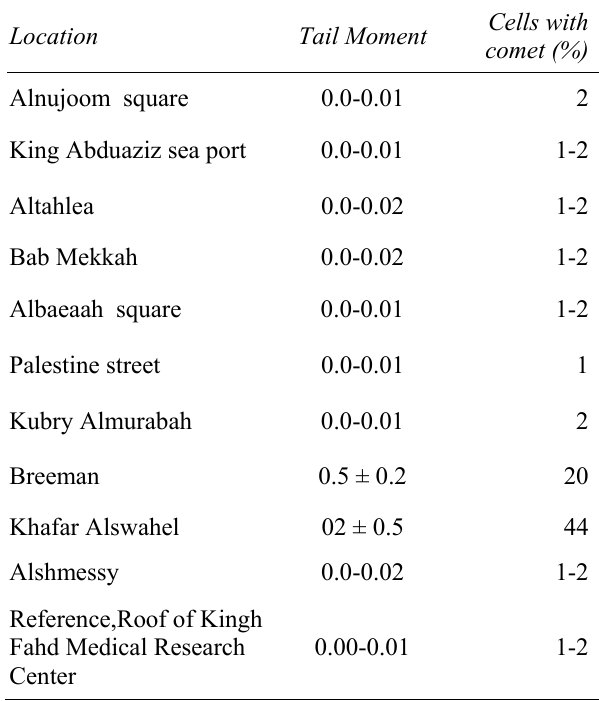
Table 3: Air particulate PM10 extractable organic